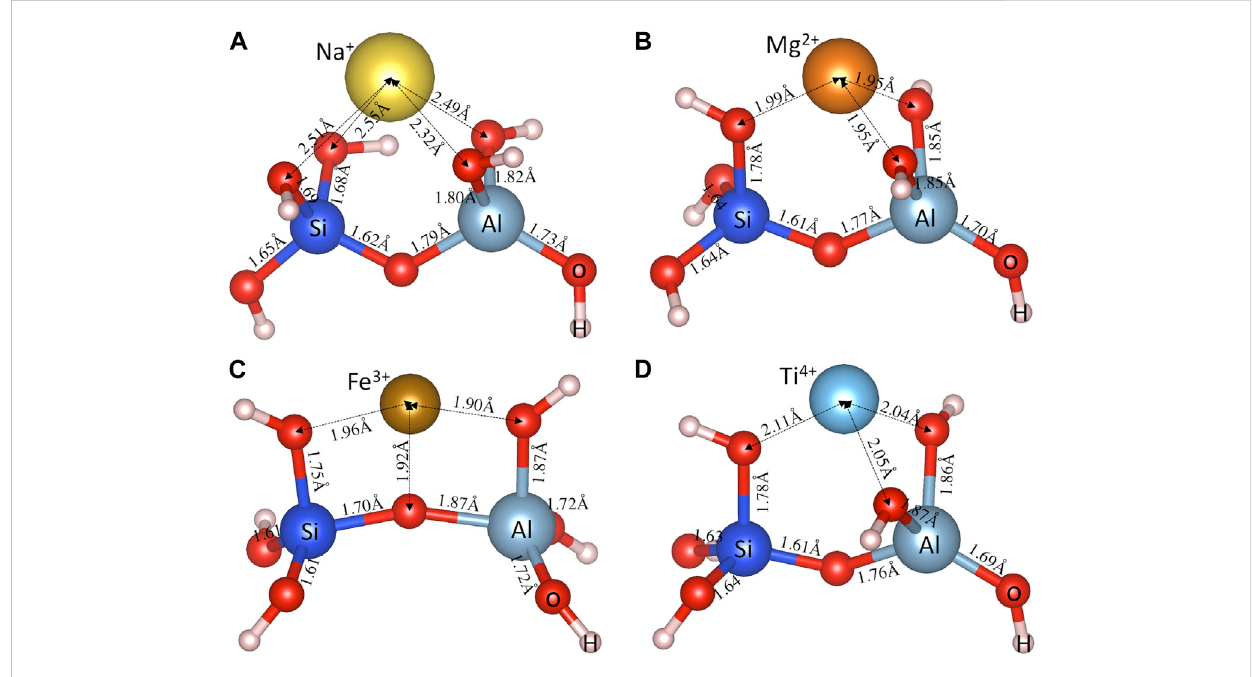
FIGURE 2 DFT-optimized aluminosilicate dimer (i.e., [(OH) 3 -Si-O-Al-(OH) 3 ] − 1 ) charge balanced by a typical (A) monovalent (Na + ), (B) bivalent (Mg 2+ ), (C) trivalent (Fe 3+ ), and (D) tetravalent (Ti 4+ ) cation. Also shown are the interatomic bond distances (in